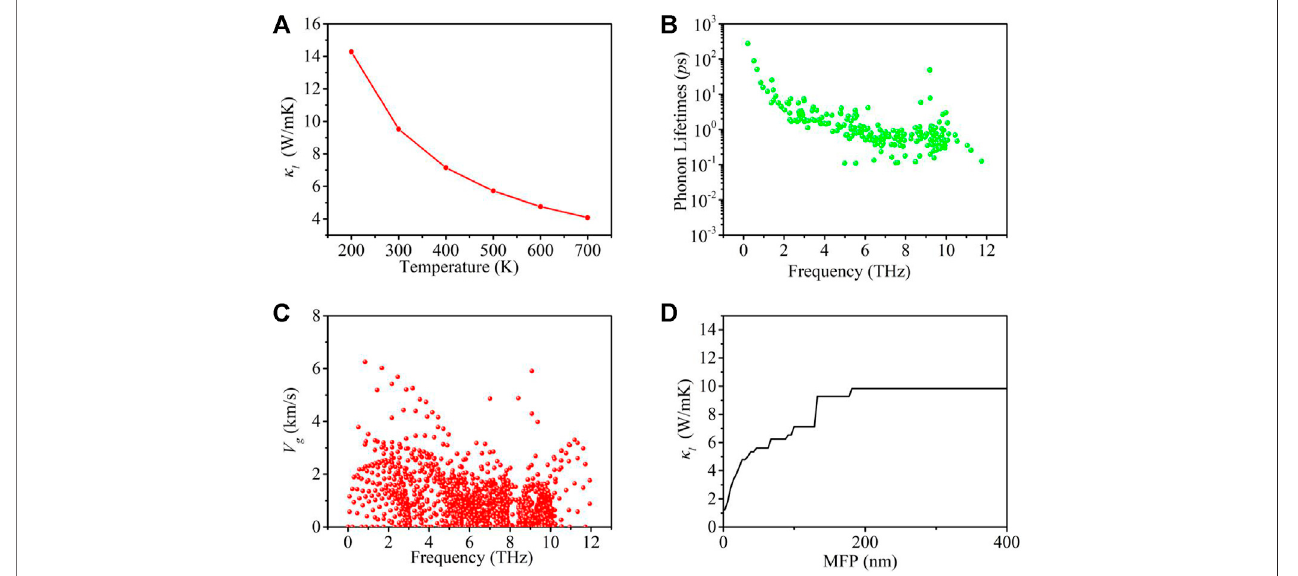
FIGURE4|(A) κ l ofmonolayerGeS 2 . (B) Phononlifetime. (C) Phonongroupvelocityasafunctionoffrequency. (D) Cumulative κ l asafunctionofthephononMFP.